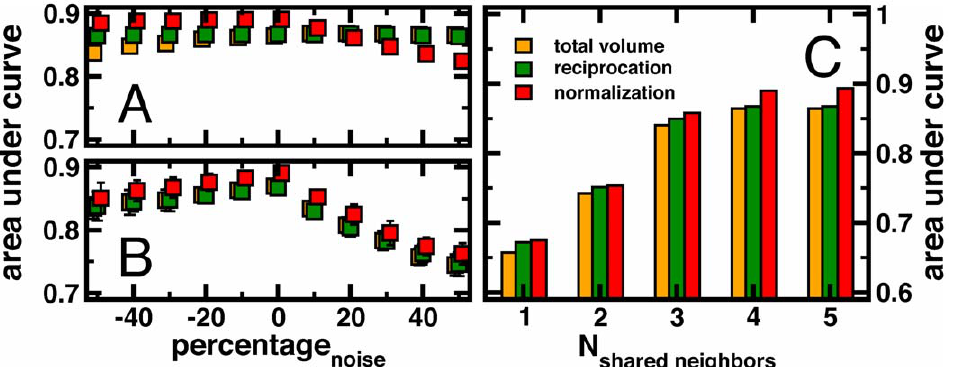
Figure 2. Noise robustness of conversion methods. In ( A ) we show results of validity tests of each method in the presence of measurement noise in the email data, where noise was simulated by randomly adding or deleting email messages in increments up to 50%. All the methods appear to be roughly robust to this type of measurement error. In ( B ) we randomly added false ties significantly lowering agreement. In ( C ) we randomly added self-reported ties, only if chosen persons share at least a certain number of common contacts as in real-life, recovering